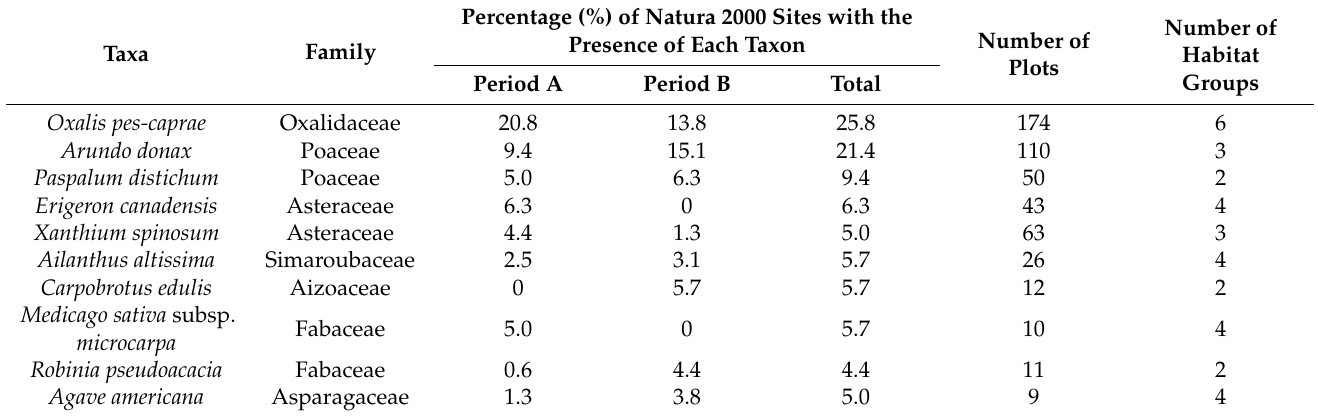
Table 1. The ten most abundant alien plant taxa, their percentage of records in regard to the number of Natura 2000 sites and the number of plots with the presence of each taxon and the number of different habitat groups where each one has been recorded. More information on invaded habitats is provided in Table